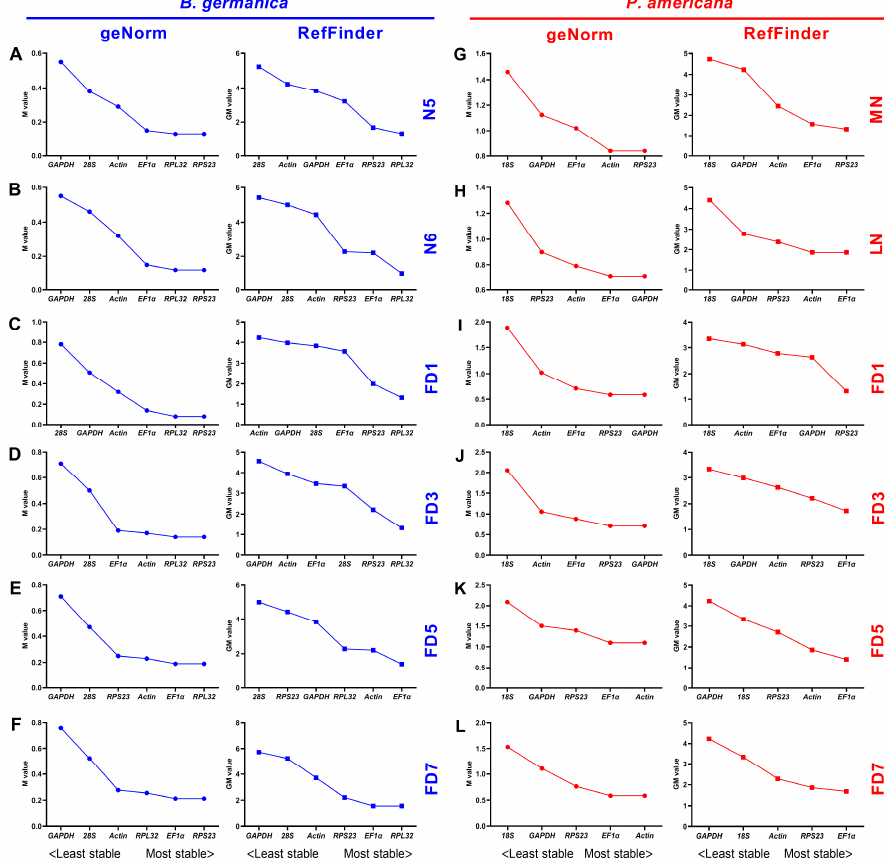
Figure 3. Expression stability rankings of candidate reference genes across various tissues at given developmental stages. The M and GM values were calculated by the geNorm and RefFinder algorithms, respectively, for candidate reference genes across various tissue types at the developmental stages of nymphs N5 ( A ) and N6 ( B ), and adults FD1 ( C ), FD3 ( D ), FD5 ( E ), and FD7 ( F ) in B. germanica . In P. americana , gene expression stability was calculated at the developmental stages of nymphs MN ( G ) and LN ( H ), and also adults FD1 ( I ), FD3 ( J ), FD5 ( K ), and FD7 ( L ).